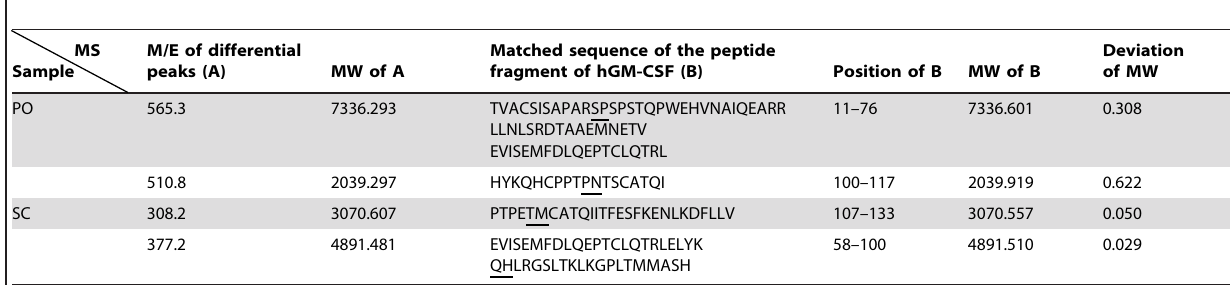
Table 3. Peptide mass fingerprinting results of rhGM-CSF in the subject serum samples after either oral administration of BmrhGM-CSF or subcutaneous injection of hGM-CSF.